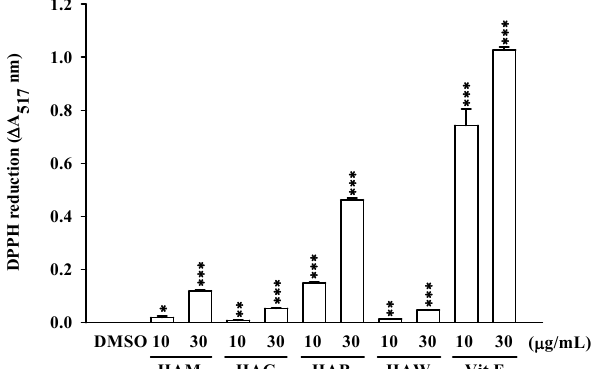
Figure 5. Effects of different crude extracts in scavenging DPPH radicals.